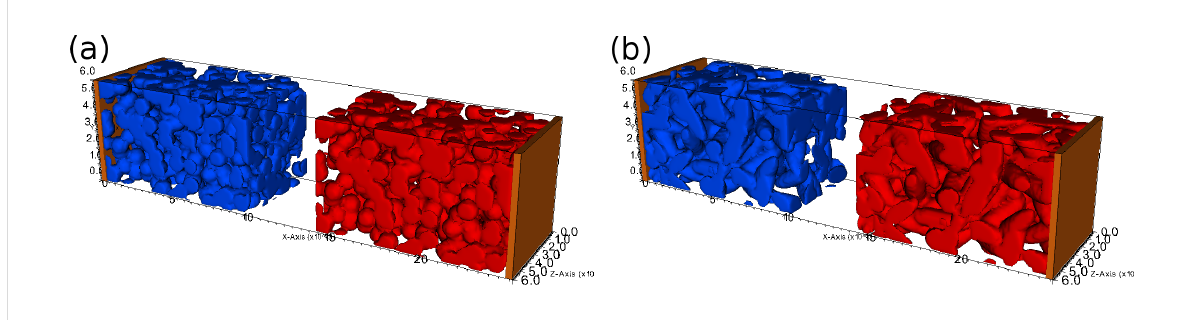
Figure 1: Geometry used for the microscopic simulation. It consists of an anode (blue), a cathode (red) and current collectors (brown). The space between particles and electrodes is filled with electrolyte. Geometry (a) consists of spherical particles of radius 5 μ m, geometry (b) of a prolate spher- oids of half-axes with 5 μ m and 16.8 μ m. The thickness of each electrode is 100 μ m, the separator region 40 μ m and the cross section area 60 × 60 μ m 2 .